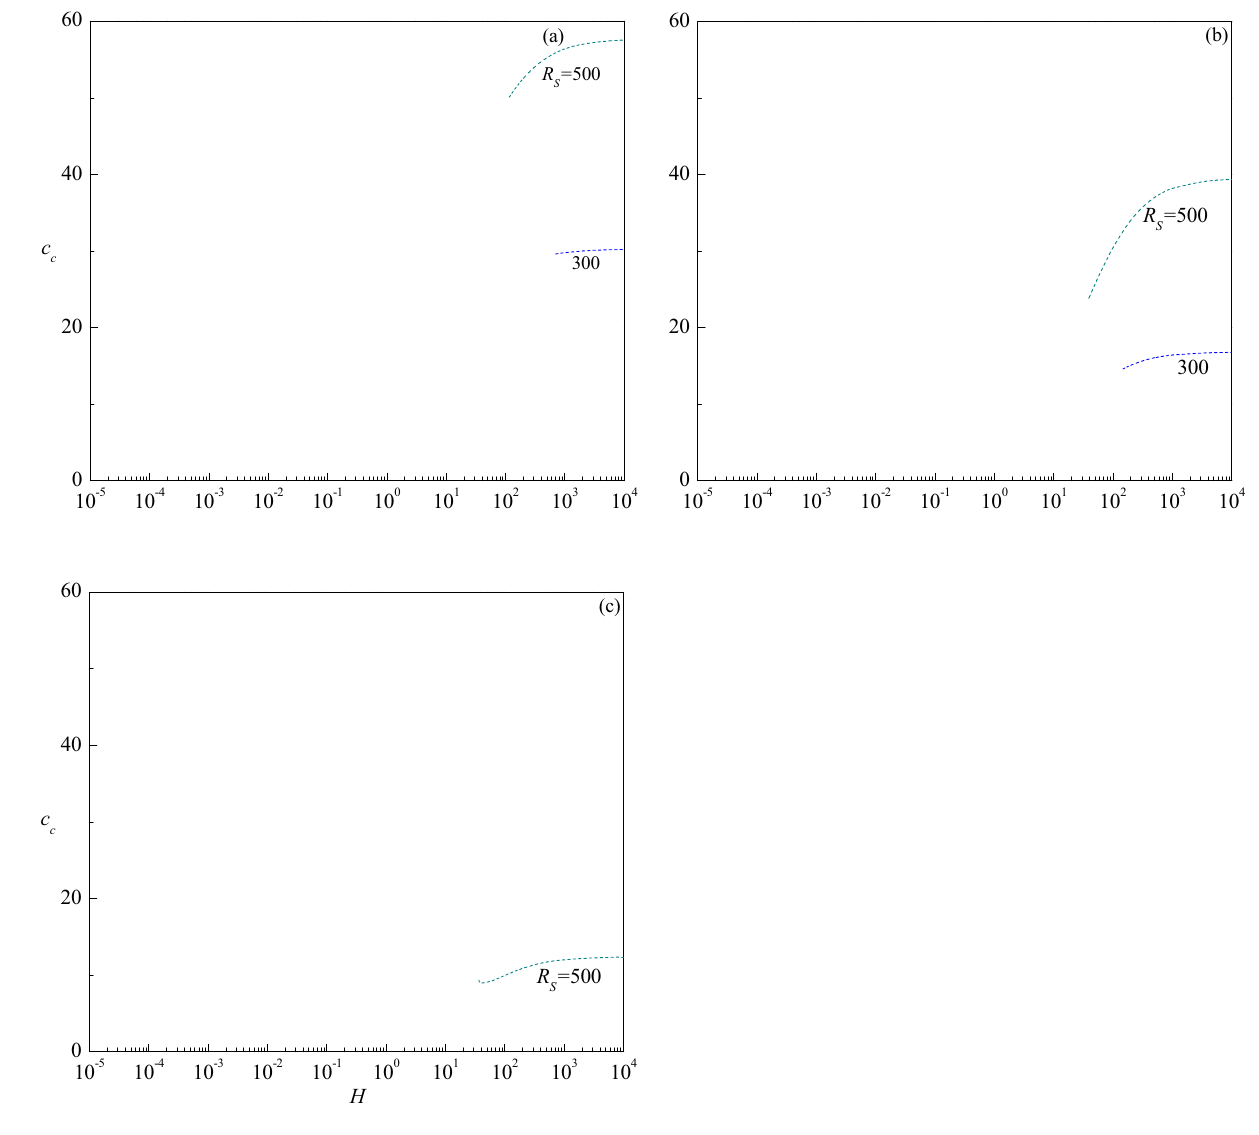
Figure 8. The variation of c c versus H for different values of R S relative to the cases ( a ) Le = 10 , ( b ) Le = 2 and ( c ) Le = 0.5 when γ = 1